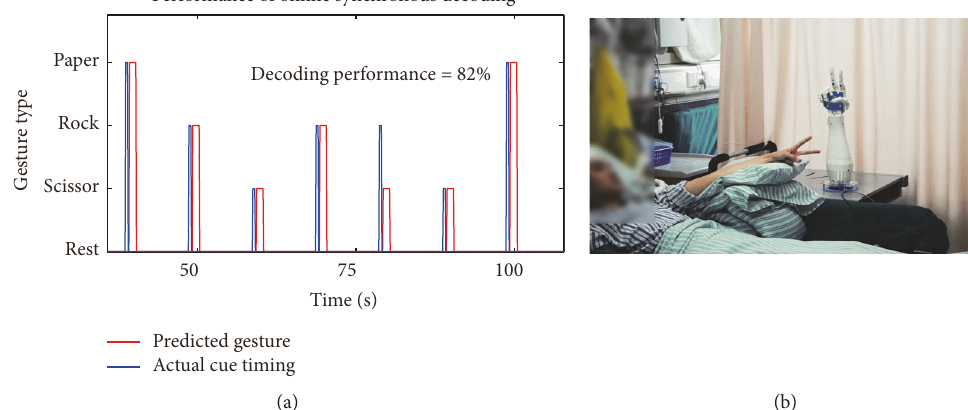
Figure 7: Real-time ECoG-based synchronous gesture types decoding performance. (a) An epoch of the real-time prosthetic hand control state of P1. Red line is the predicted gesture state, and the blue line is the actual visual cue timing. The real-time decoding performance of that session is 82%. (b) The photo taken at the experiment